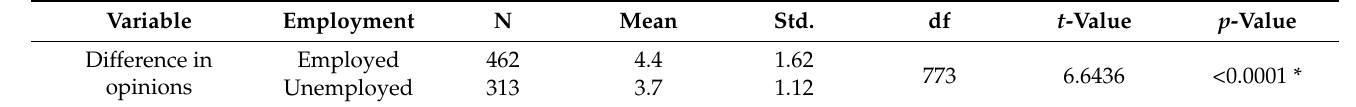
Table 6. Difference in the store factors influence for purchasing luxury brands (by